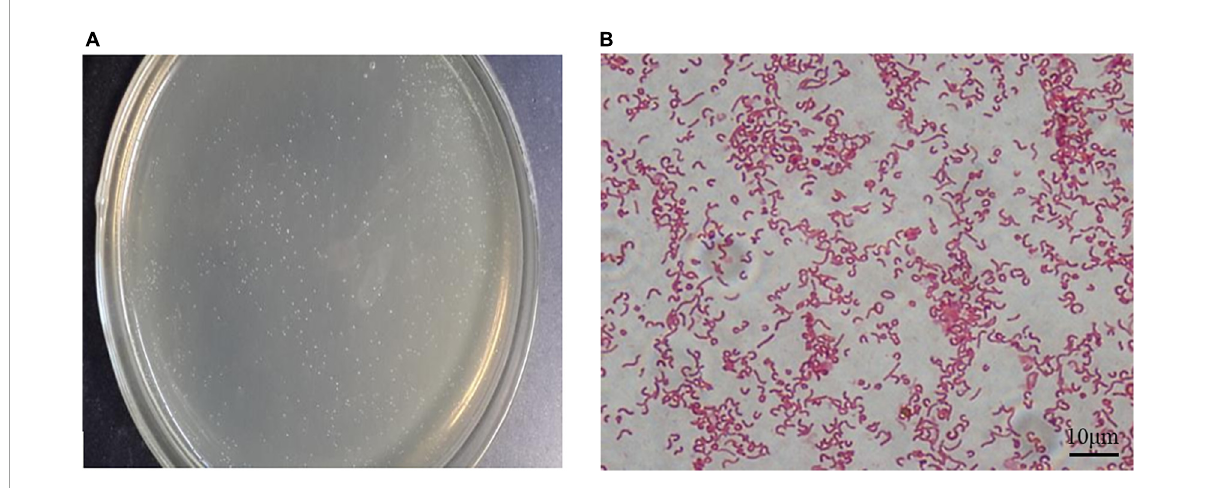
FIGURE2 Cultivation of the Helicobacter pylori Sydney strain 1 (SS1) strain in vitro . (A) Typical white needle tip colonies could be seen on the plates after 72 h of incubation. (B) Bacterial flagella were observed after alkalescent carbolfuchsin staining. Scale bar = 10 µ